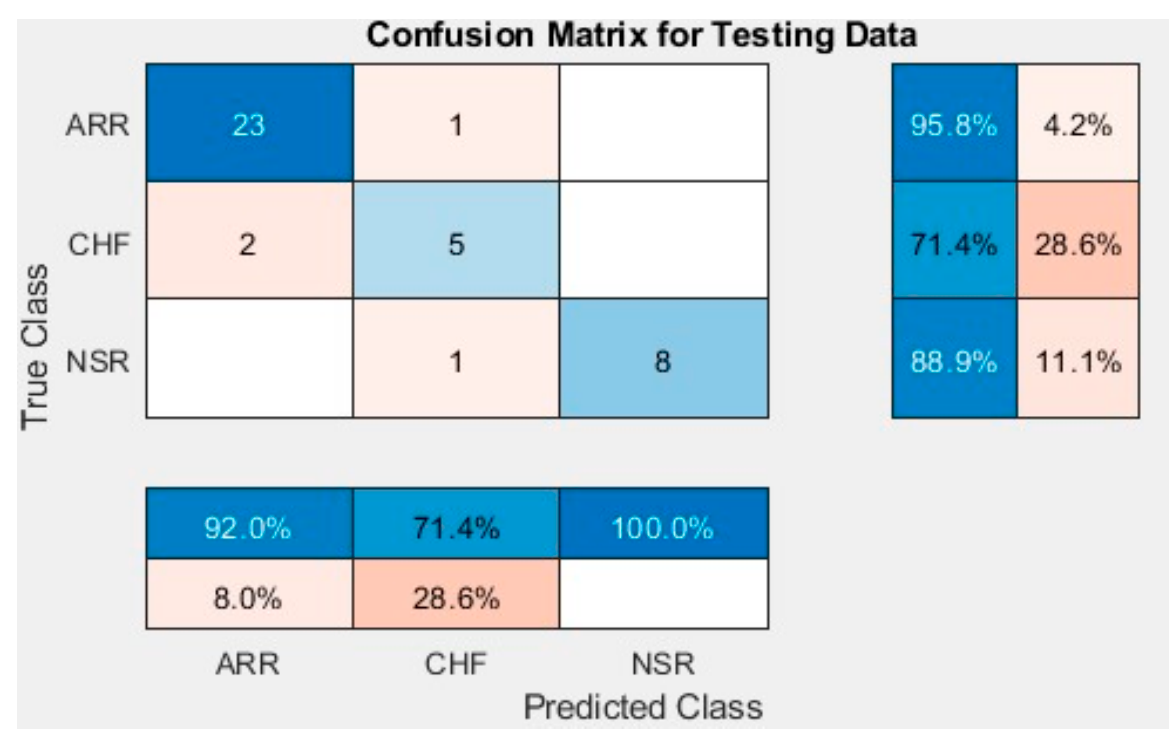
Figure 15. Confusion matrix for the testing set of the proposed hybrid BA-CNN-LSTM algorithm. Since it is a classification problem, the t -test was not applicable, as the error is either zero or one. The following Figure 16 shows the validation accuracy for all four algorithms using 10-fold